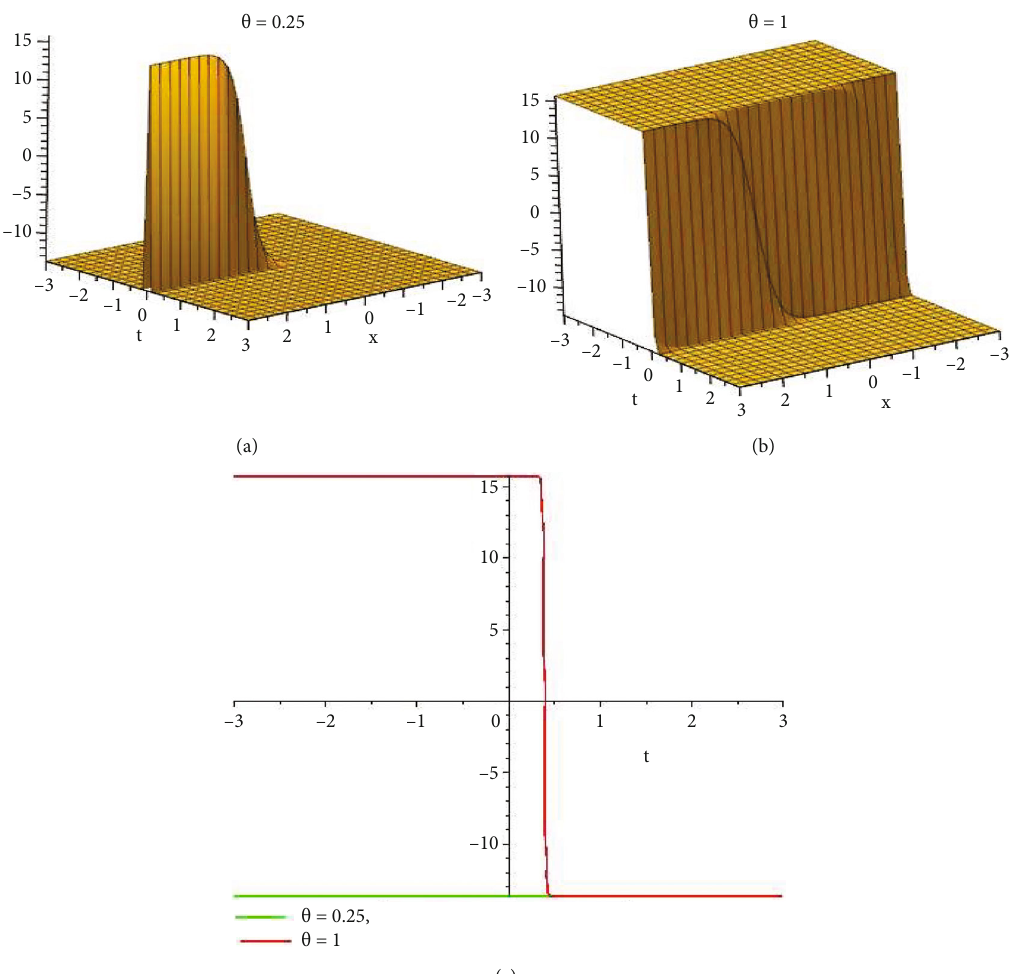
, y , t Þ . (a, b) 3D plot and (c) 2D combined plot for x = 1 2 ð x